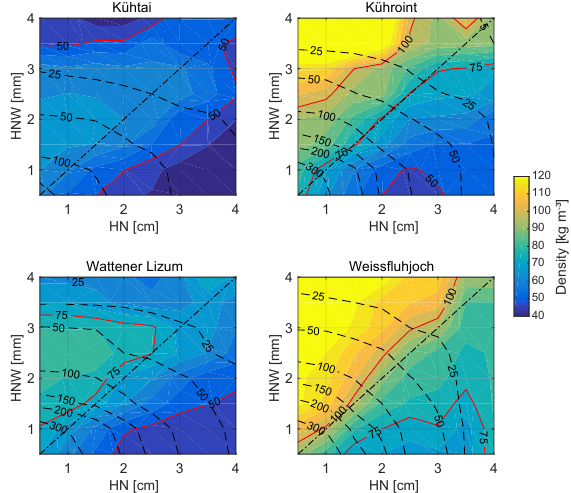
Figure 2. Median new snow densities (colour scale) calculated us- ing all data exceeding different minimum limits of the height of new snow (HN) and the water equivalent of snowfall (HNW) for period 1 (1 October 2013–20 May 2015). Note that multiples of 25kgm − 3 are highlighted with red contour lines. The labelled black dashed lines give the count of the hourly data remaining after filtering. The straight dotted and dashed lines show results for equal minimum limits of HN (cm) and HNW